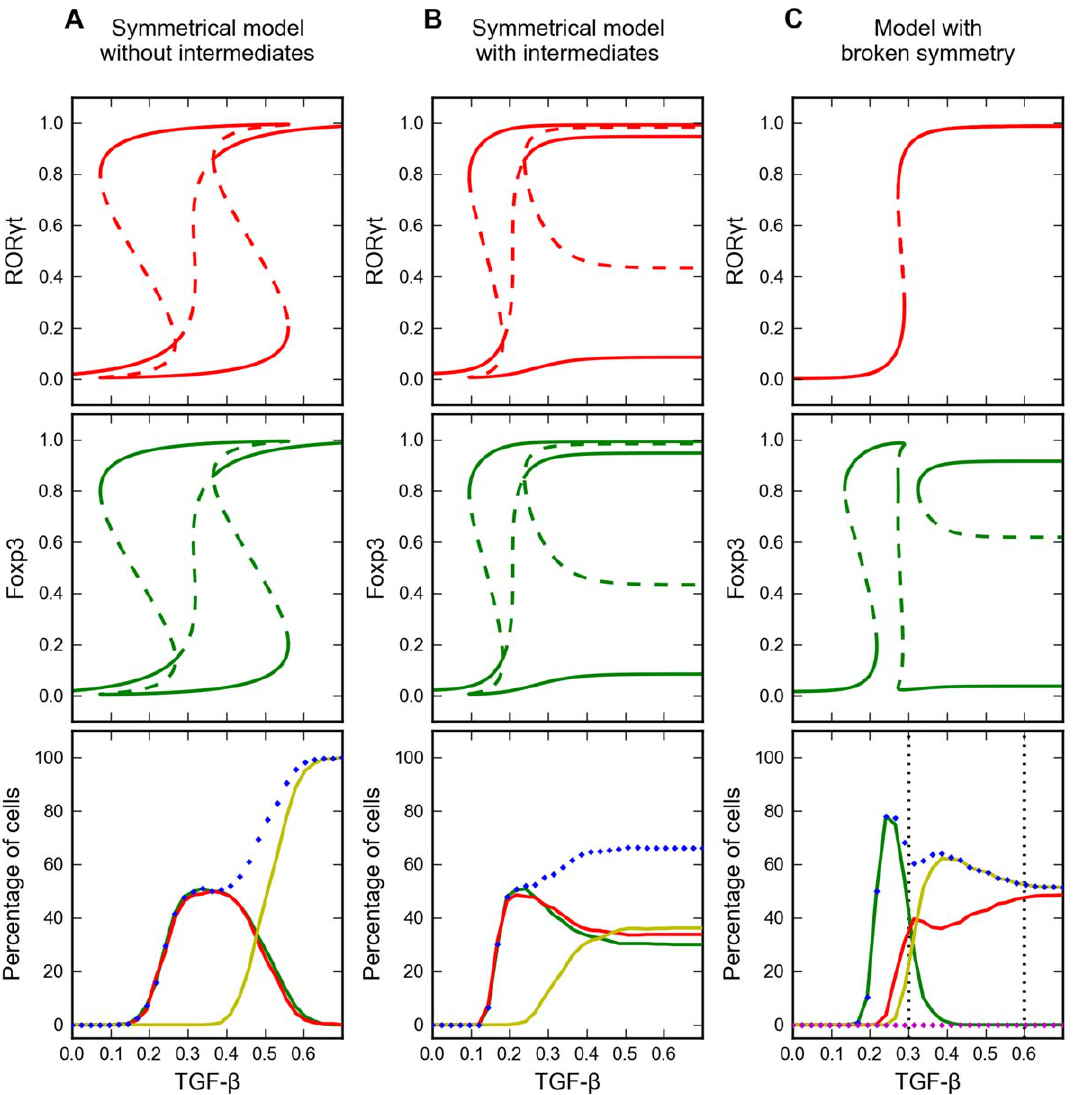
Figure 4. Bifurcation diagrams and signal-response curves for three models. Upper and middle panels: one-parameter bifurcation diagrams for the average cell. Steady state levels of ROR c t and Foxp3 are plotted as functions of TGF- b concentration. Solid line: stable steady states. Dashed line: unstable steady states. Lower panels: signal-response curves. For each point on the abscissa (for [TGF- b ]=constant), we simulate induced differentiation of a population of 1000 cells. Percentages of cells at the alternative steady states are plotted as functions of TGF- b concentration used for induction. Red line: ROR c t-only cells. Green line: Foxp3-only cells. Yellow line: double-expressing cells. Blue marker: Foxp3- expressing cells. Magenta marker: IL-17 producing cells. A. Symmetrical model without intermediates. B. Symmetrical model with intermediates. C. Asymmetric model. Dotted vertical lines denote representative experimental levels of TGF- b .